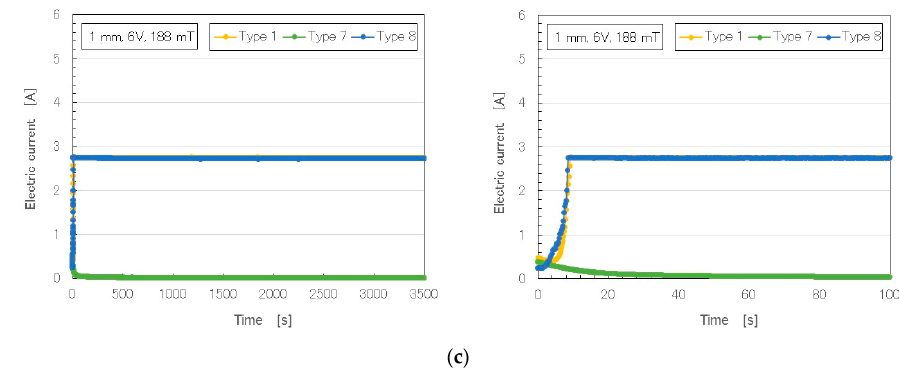
Figure 3. Time changes of temperature, voltage and electric current of MCF rubber under electrolytic polymerization: ( a ) temperature; ( b ) voltage; ( c ) electric current.